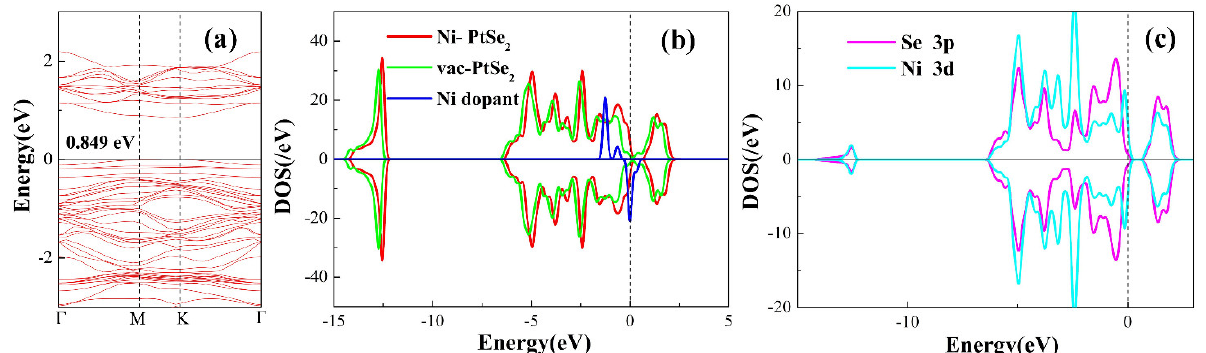
Figure 3. ( a ) BS of the Ni-PtSe 2 system, ( b ) DOS comparison, and ( c ) partial DOS. The value in the BS is the bandgap, and the dashed line in DOS is the Fermi level.